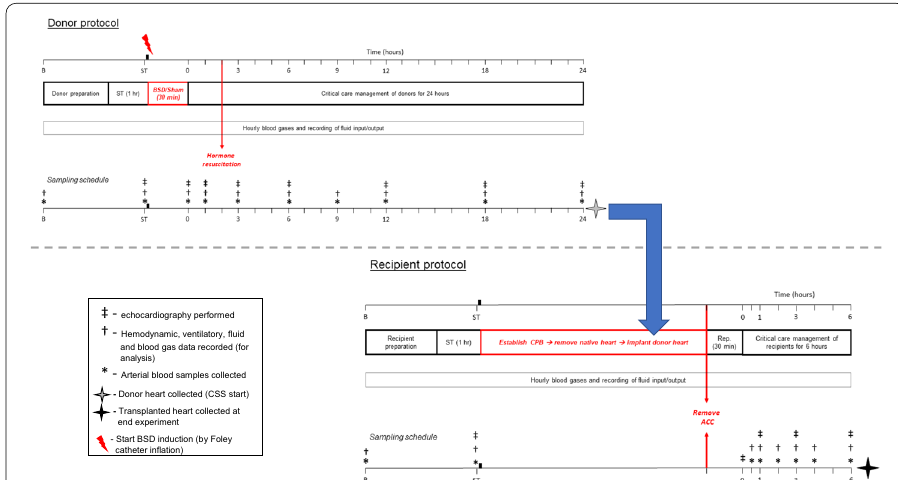
Fig. 1 Experimental timeline for donor BSD and subsequent HTx . All sheep were approved for use by the facility veterinarian after a comprehensive health check. Prior to allocation, experimental sheep were matched for weight and blood compatibility [17], then paired and randomly assigned to either donor sham (control without neurological injury) or BSD groups ( n 4/group). Sheep within each pair were then = randomly allocated as an experimental donor or recipient. Following standard instrumentation